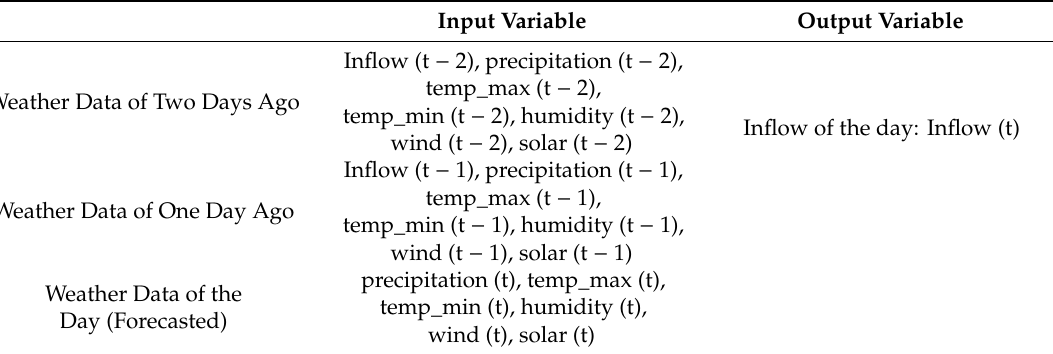
Table 1. The input data for machine learning models.